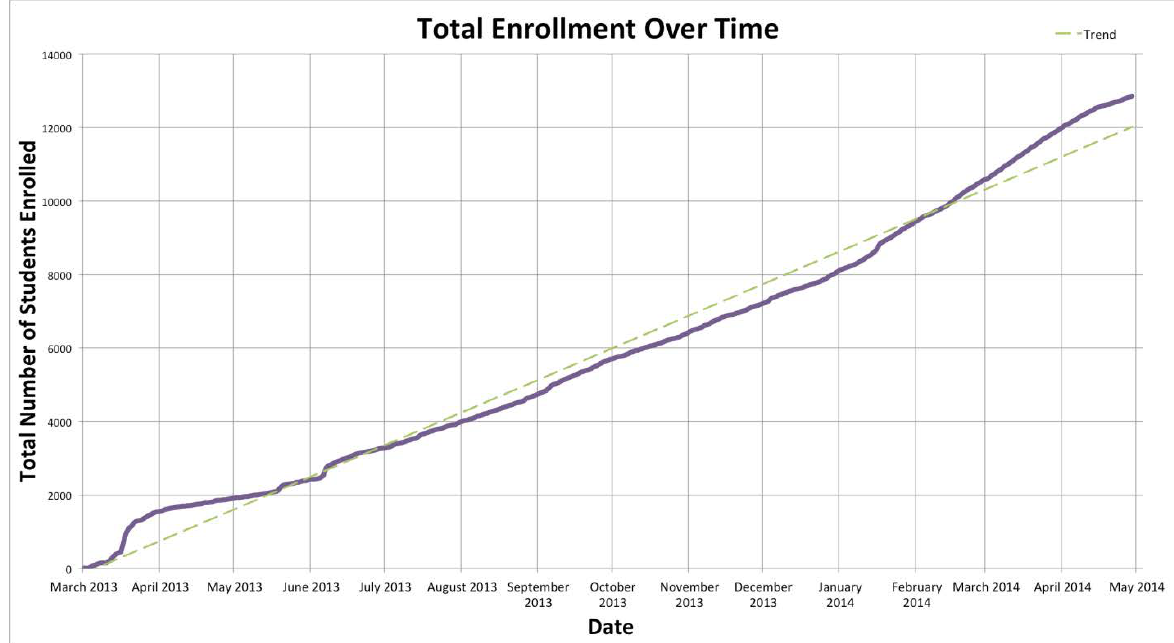
Figure 2. Enrollment in Astronomy – State of the Art over the first 14 months of the online course. The initial surge of enrollment was from recruitment of likely audiences based on prior astronomy interest. The course entered the Udemy marketplace in late March, 2013. Enrollment bumps in May and June 2013 were due to cross-marketing within Udemy and the rate of enrollment has shown grown steadily over the course of the past year to be twice as high as it was near the start of the